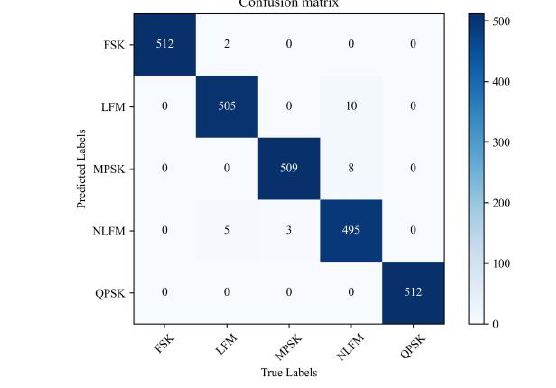
Fig. 5. Confusion matrix of the algorithm this